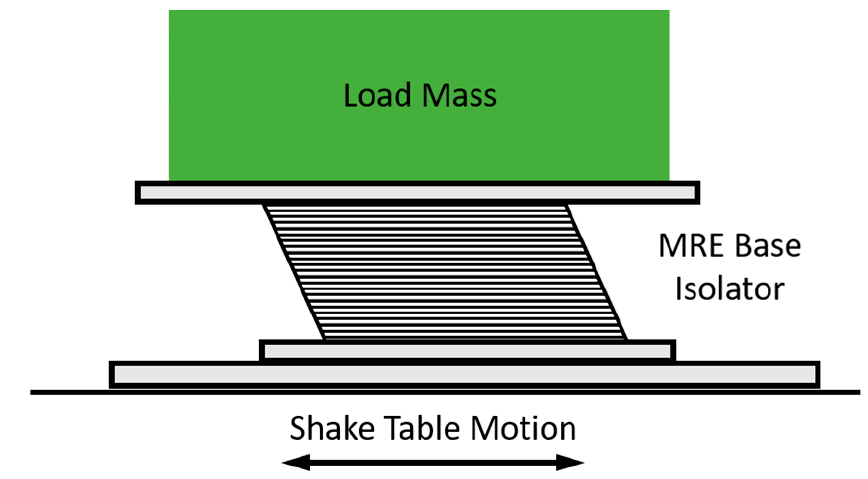
Figure 15. MRE base isolator schematic illustration [175].